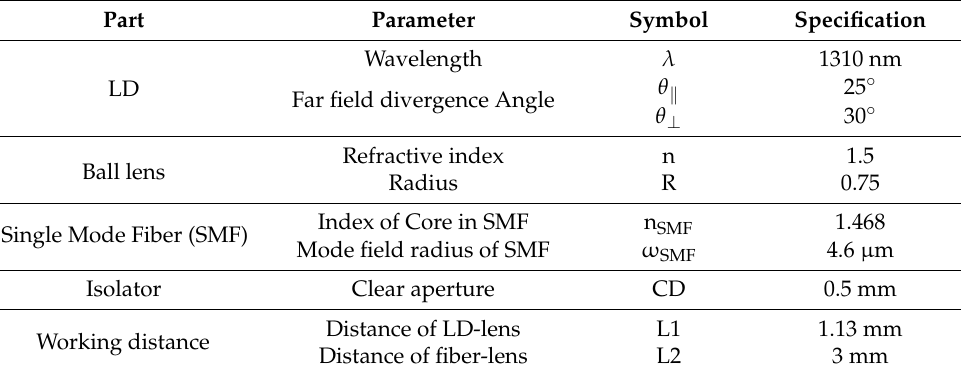
Table 2. Parameters of